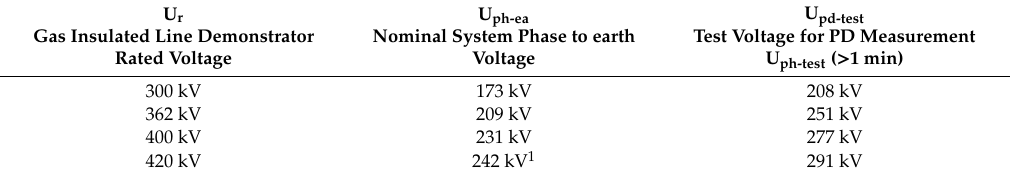
Table 2. Gas insulated line demonstrator partial discharge test voltage